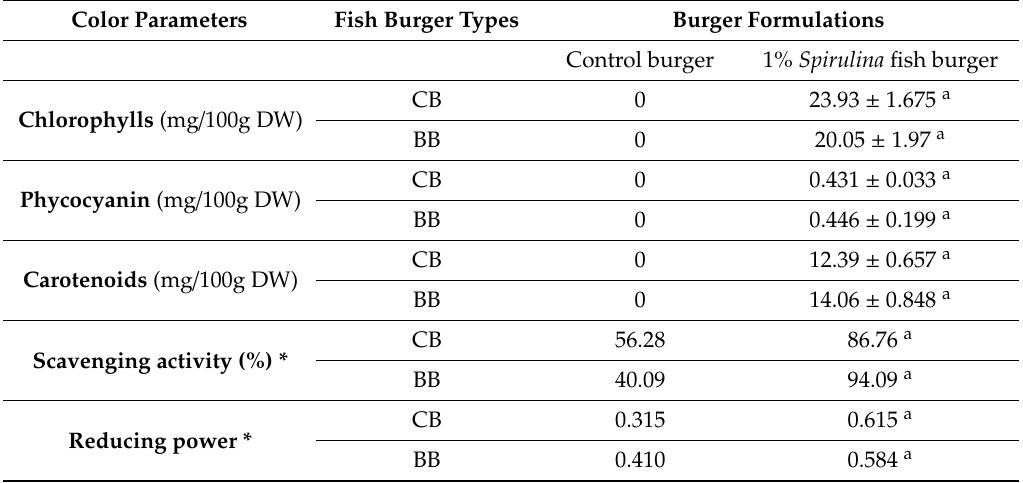
Table 6. Pigments content and antioxidant activities of control and 1% Spirulina -fortified burgers. Color Parameters Fish Burger